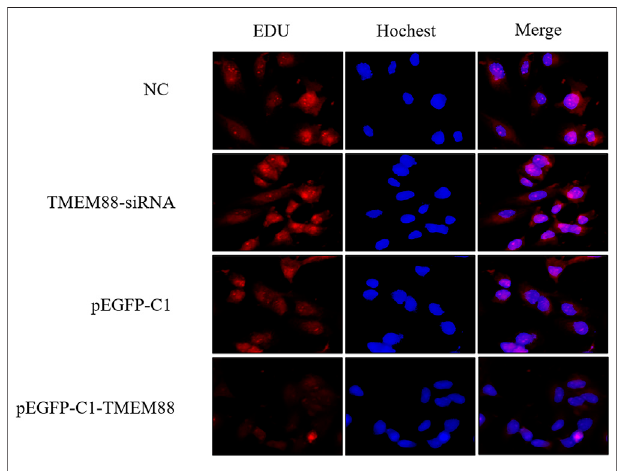
FIGURE 6 | TMEM88 inhibited the proliferation of AML-12 cells stimulated by FFA. (A) Edu staining detected the effect of TMEM88 on the proliferation of AML-12 cells stimulated by FFA. The image of AML-12 cells stainedbyEdu (red) representscellproliferation, and Hochest (blue) was used to mark the cell nucleus.